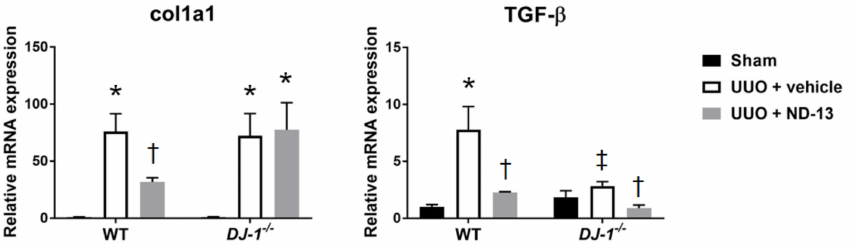
Figure 1. Treatment with ND-13 reduces the unilateral ureter obstruction (UUO)-induced renal expression of fibrotic markers in wild type (WT) mice, but not in DJ-1 − / − mice. Relative mRNA expression of markers of fibrosis col1a1 and TGF- β in renal cortex of WT and DJ-1 − / − mice that underwent sham surgery, UUO and vehicle treatment or UUO and ND-13 treatment. N = 4–5 / group; * p < 0.05 vs. same genotype sham, † p < 0.05 vs. same genotype UUO + vehicle, ‡ p < 0.05 vs. WT UUO + vehicle; two-way ANOVA with Tukey’s post-hoc